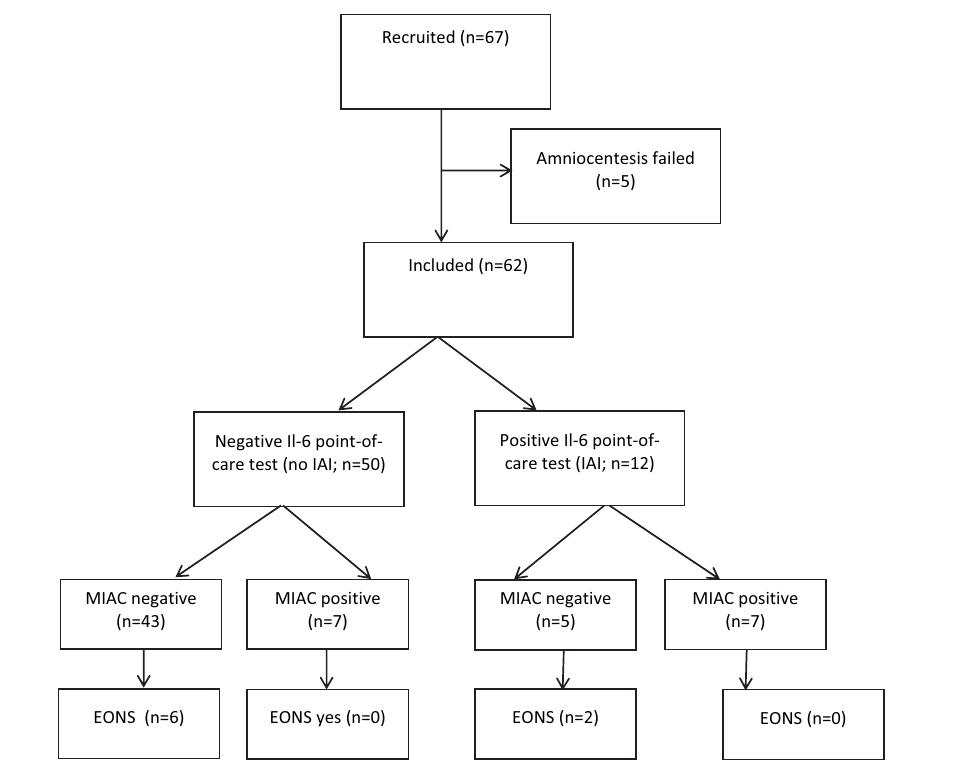
Fig. 5. Flowchart of the